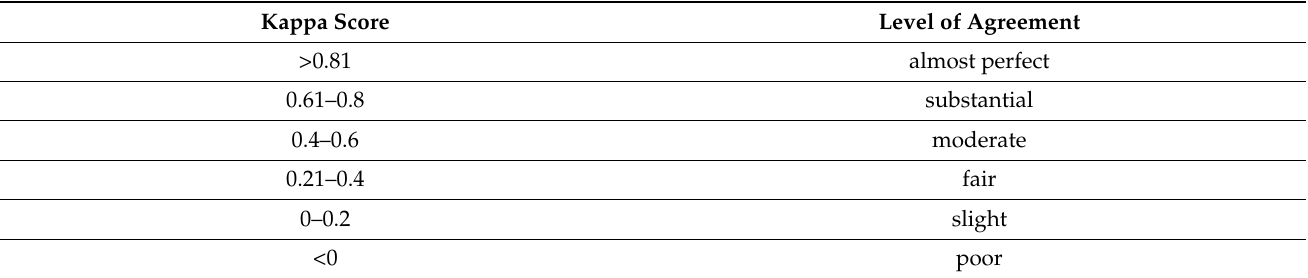
Figure 5. The mean percent of fire area in each severity class across all 27 case study fires when mapped with Sentinel 2 and Landsat 8 sensors. Table 5. Kappa score definitions